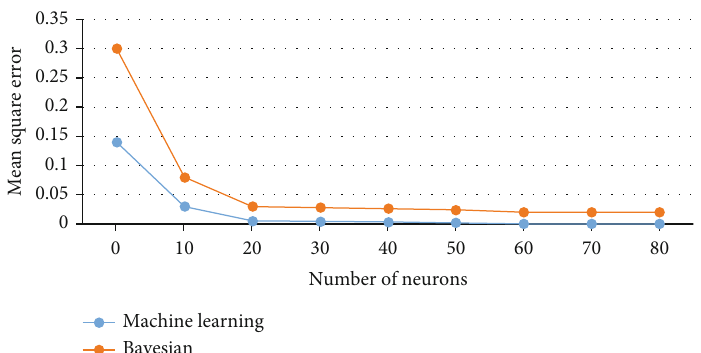
Figure 6: The optimum number of neurons is estimated using the least mean square error function value in the range from 1 to 80. Table 3: Hidden layers ’ number against the mean square error and the correlation factors for di ff erent models, where the adsorption parameters (pressure and temperature) are selected using the Bayesian ordered function with the least mean square error values. Model